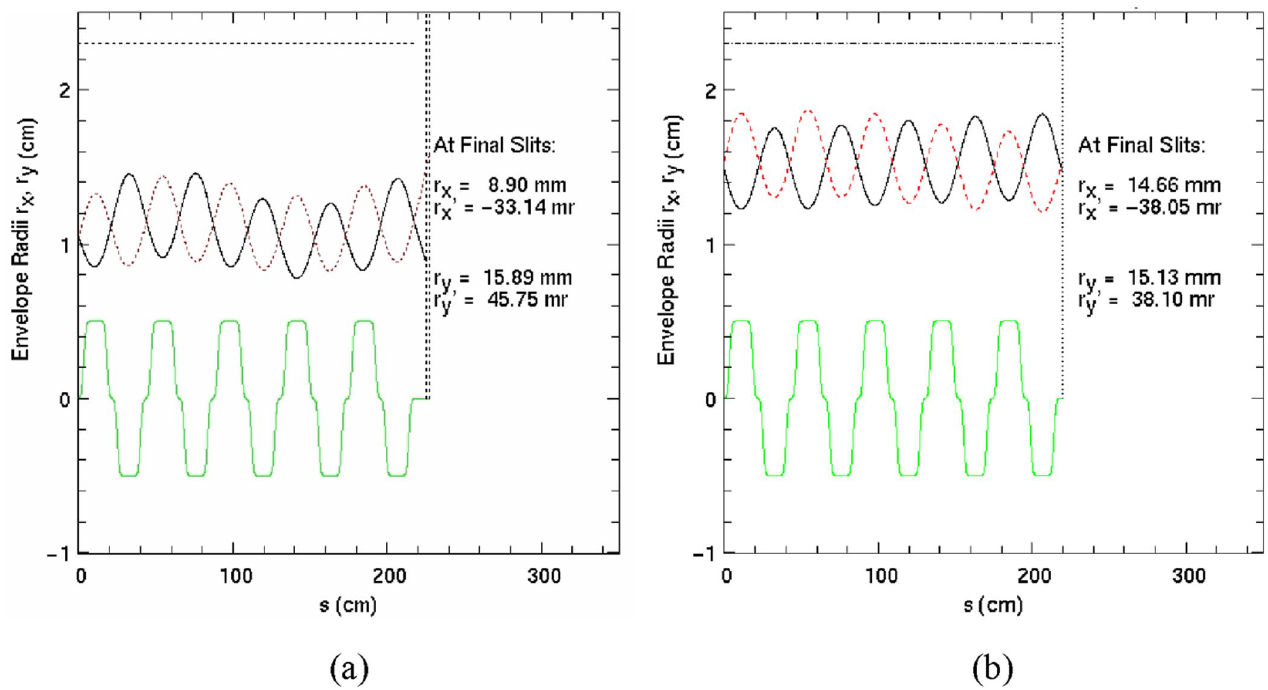
FIG. 18. (Color) Calculated envelope from QD1 to D2 for (a) a 60% fill factor case and (b) an 80% fill factor case. Runs are initialized with data taken at QD1. Black: horizontal direction; red: vertical direction; green: focusing forces quadrupole gradients.